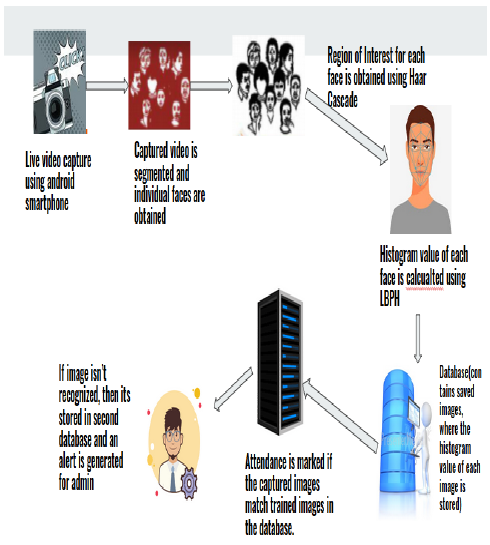
Figure 8. Proposed workflow and